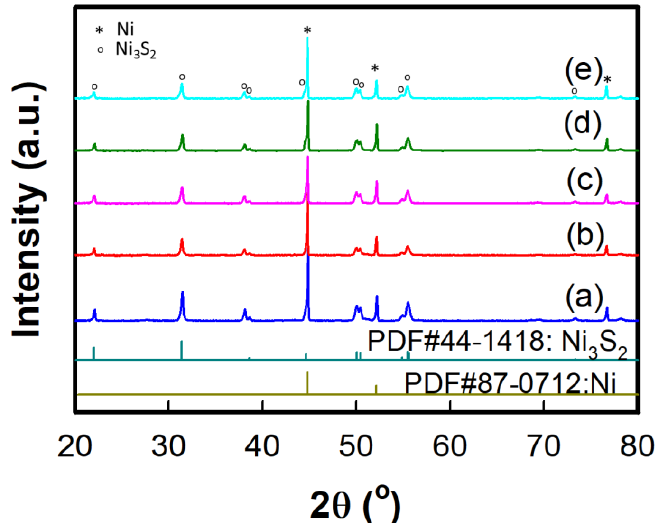
Figure 2. XRD patterns of the ( a ) N 3 S 2 , ( b ) Co 0.3 –Ni 3 S 2 , ( c ) Co 0.4 –Ni 3 S 2 , ( d ) Co 0.5 –Ni 3 S 2 , and ( e ) Co 0.6 –Ni 3 S 2 electrodes.